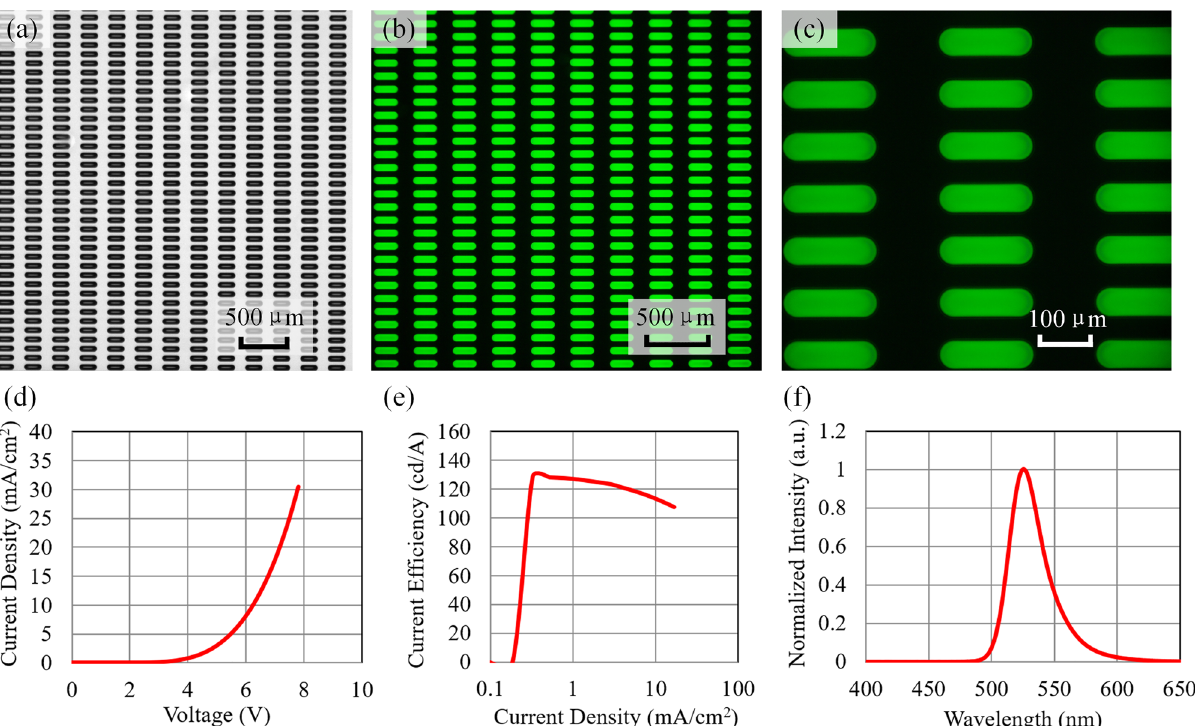
Figure 12. Printing and lighting results for a 400 cm 2 , 85 PPI OLED panel. ( a ) Printing results. ( b ) Lighting results. ( c ) Illuminated pixels under a 5 × microscope. ( d ) J–V curve of the printed device. ( e ) CE–J curve of the printed device. ( f ) EL spectrum of the printed